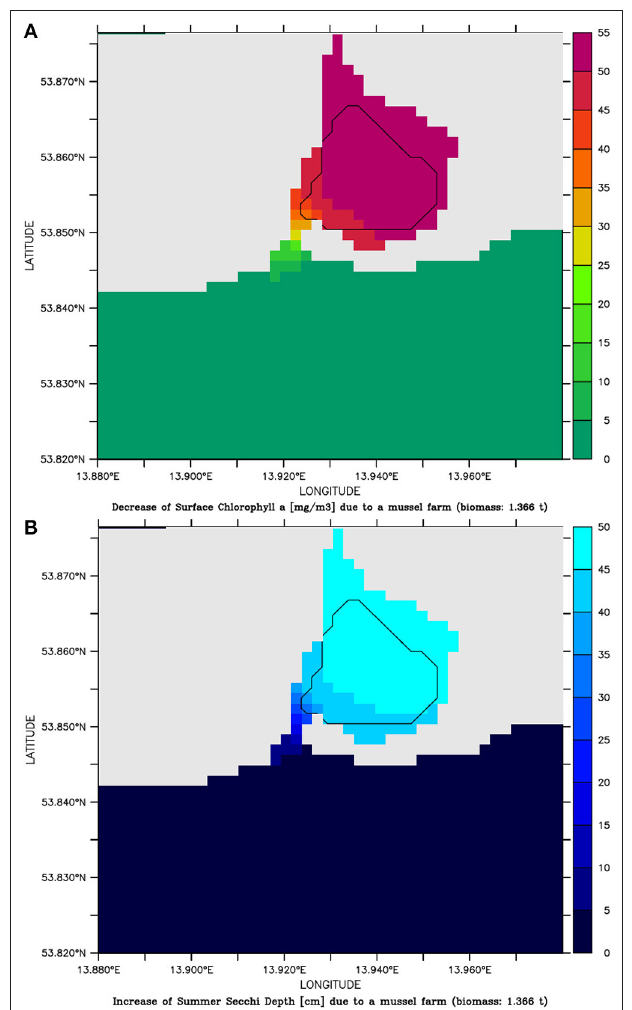
FIGURE 3 | (A) decrease of Chlorophyll a conc. [mg m − 3 ] and (B) increase of Summer Secchi Depth [cm] and in the simulation assuming a mussel farm with a density of 1g l − 1 in Lake Usedom compared to the simulation without